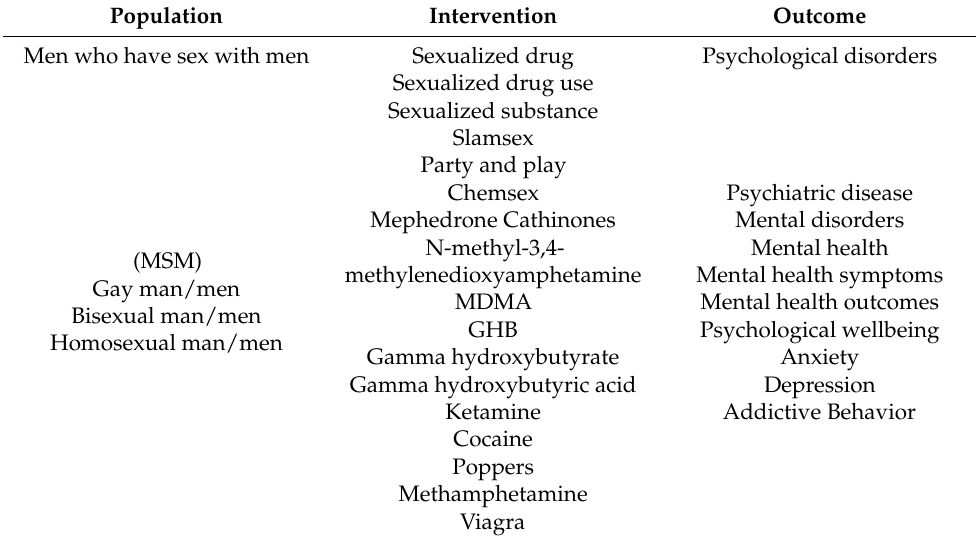
Table 1. Search strategy